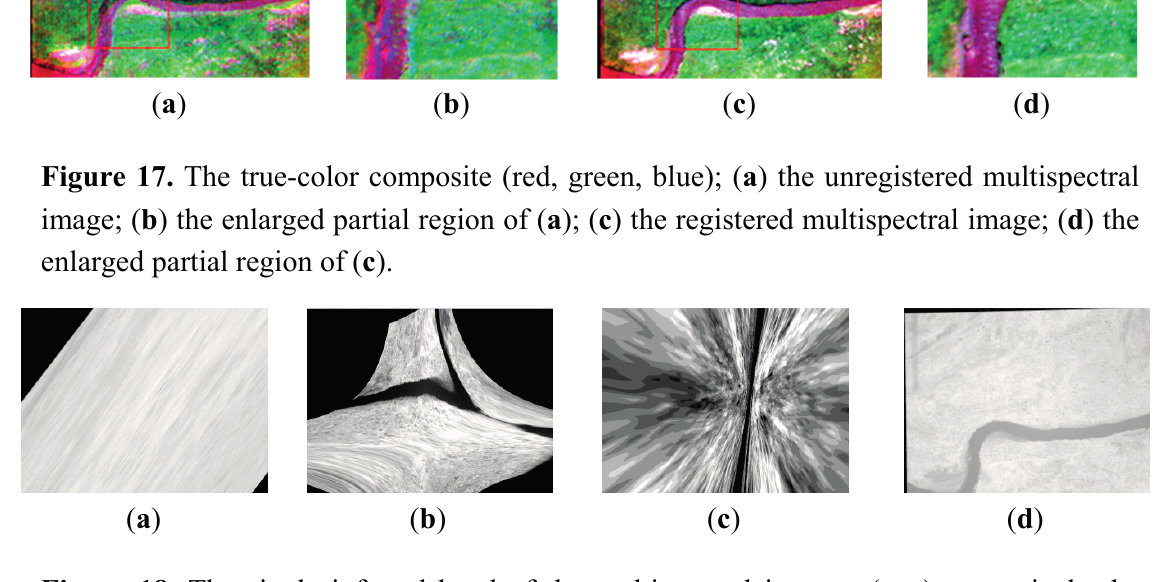
Figure 18. The single infrared band of the multispectral images; ( a – c ) respectively the infrared bands obtained by using the methods using the first-order polynomial, second-order polynomial and homography model and using the RANSAC directly; ( d ) the infrared band obtained by using our method.